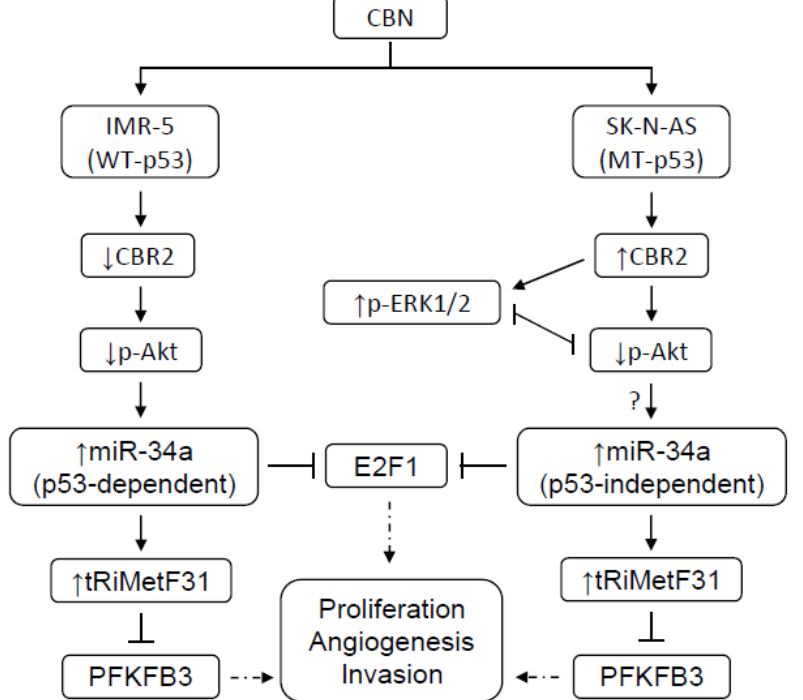
Figure 7. Proposed model for CBN’s anti-neuroblastoma mechanism. CBN’s antineuroblastoma effects may be mediated through CBR2-dependent and –independent mechanisms, leading to the inhibition of the AKT pathway and a p53-dependent or -independent transactivation of miR-34a. miR-34a, in turn, directly silences E2F1 and guides the production of tRiMetF31, which targets PFKFB3, eventually resulting in the suppression of neuroblastoma proliferation, invasion, and angiogenesis.